Question: According to the figure, is the described quantity increasing or decreasing?
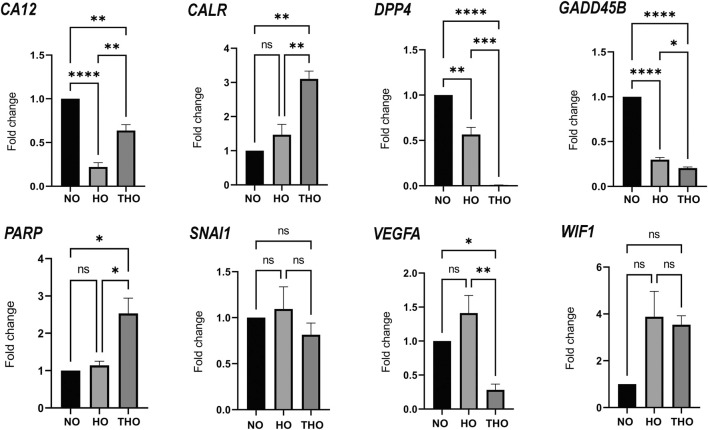
Answer: increasing